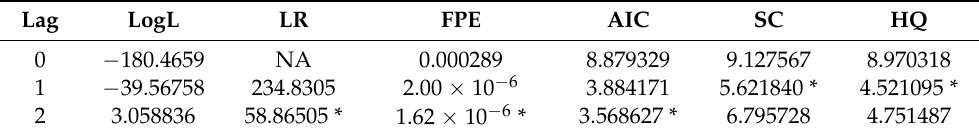
Table 4. Lag selection for the ARDL